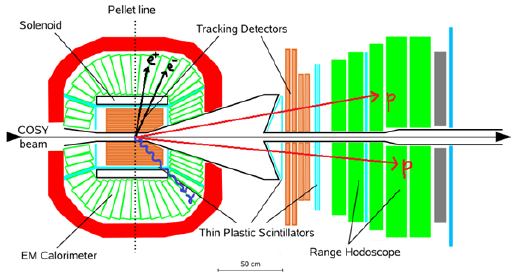
Figure 1. A typical η meson decay in the WASA (Wide Angle Shower Apparatus) detector.